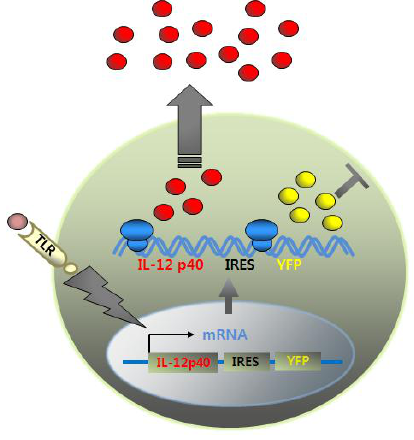
Figure 5. How the cytokine reporter system works. YFP gene is linked to IL-12 p40 gene via IRES element. When DCs are stimulated with TLR ligands, induction of IL-12 p40 gene generates bicistronic transcript encoding both IL-12 p40 and YFP gene. While IL-12 p40 proteins are secreted extracellulary, YFPs remain in the cytosol, marking cells